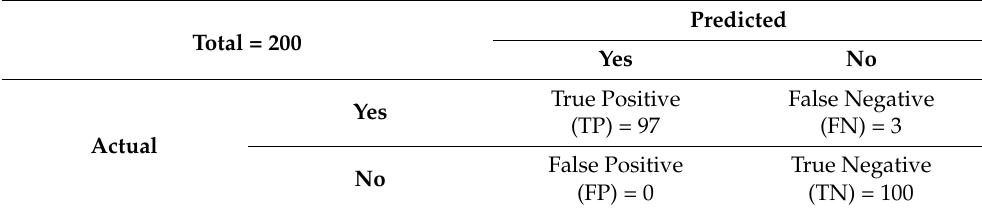
Table 9. Results for Relay#1.